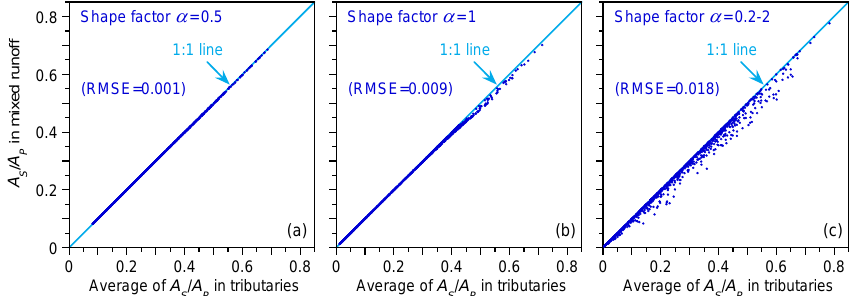
Figure 8. Amplitude ratio ( A S /A P ) of tracer cycles in precipitation and mixed runoff from the same 1000 synthetic catchments shown in Fig. 7 (vertical axes), compared to the average of the tracer cycle amplitude ratios in the two tributaries (horizontal axes). As in Fig. 7, each synthetic catchment comprises two subcatchments with individual MTTs randomly chosen from a uniform distribution of logarithms spanning the interval between 0.1 and 20 years, and with each pair of MTTs differing by at least a factor of 2. In (a) and (b) , all subcatchments have the same shape factor α . In (c) , shape factors for each subcatchment are randomly chosen from a uniform distribution between α = 0.2 and α = 2. The close fits to the 1:1 lines, and the small root-mean-square error (RMSE) values, show that the tracer cycle amplitudes from the tributaries are averaged almost exactly in the mixed